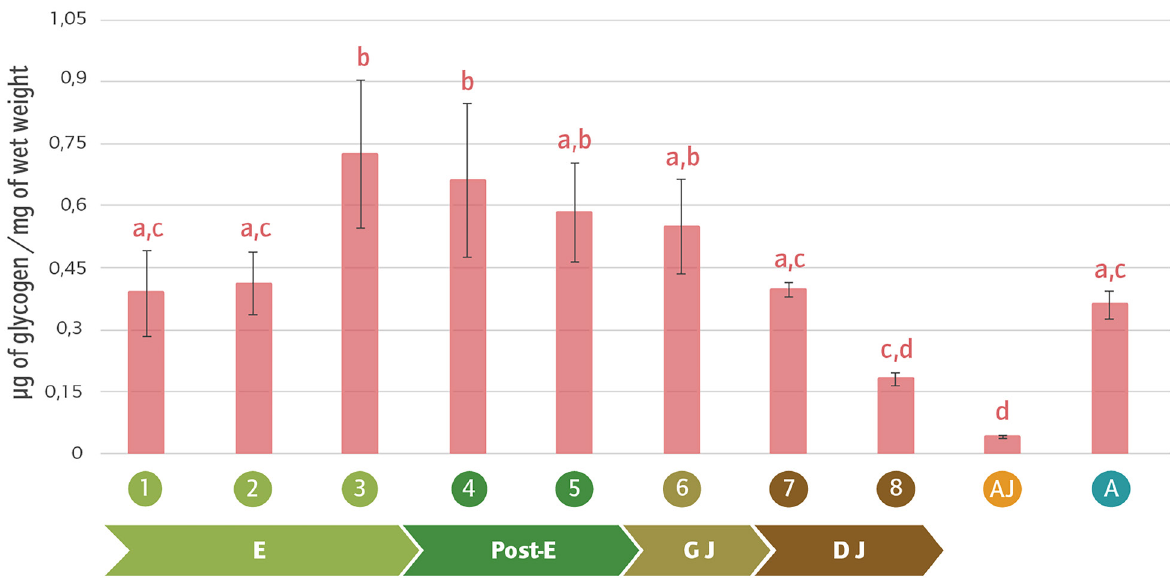
Figure 6. Analysis of glycogen concentration during P. pythagoricus development until adult’s stage. Values are the means ± SDs. Different letters above the bars indicate significant differences among the different stages at p < 0.05, as determined by Tukey’s post hoc test. 1 to 8: stages of P. pythagoricus development; AJ: advanced juvenile stage; A: adult stage; E: embryonic period; Post-E: post-embryonic period; GJ: juveniles in gregarious stage; DJ: juveniles in dispersal